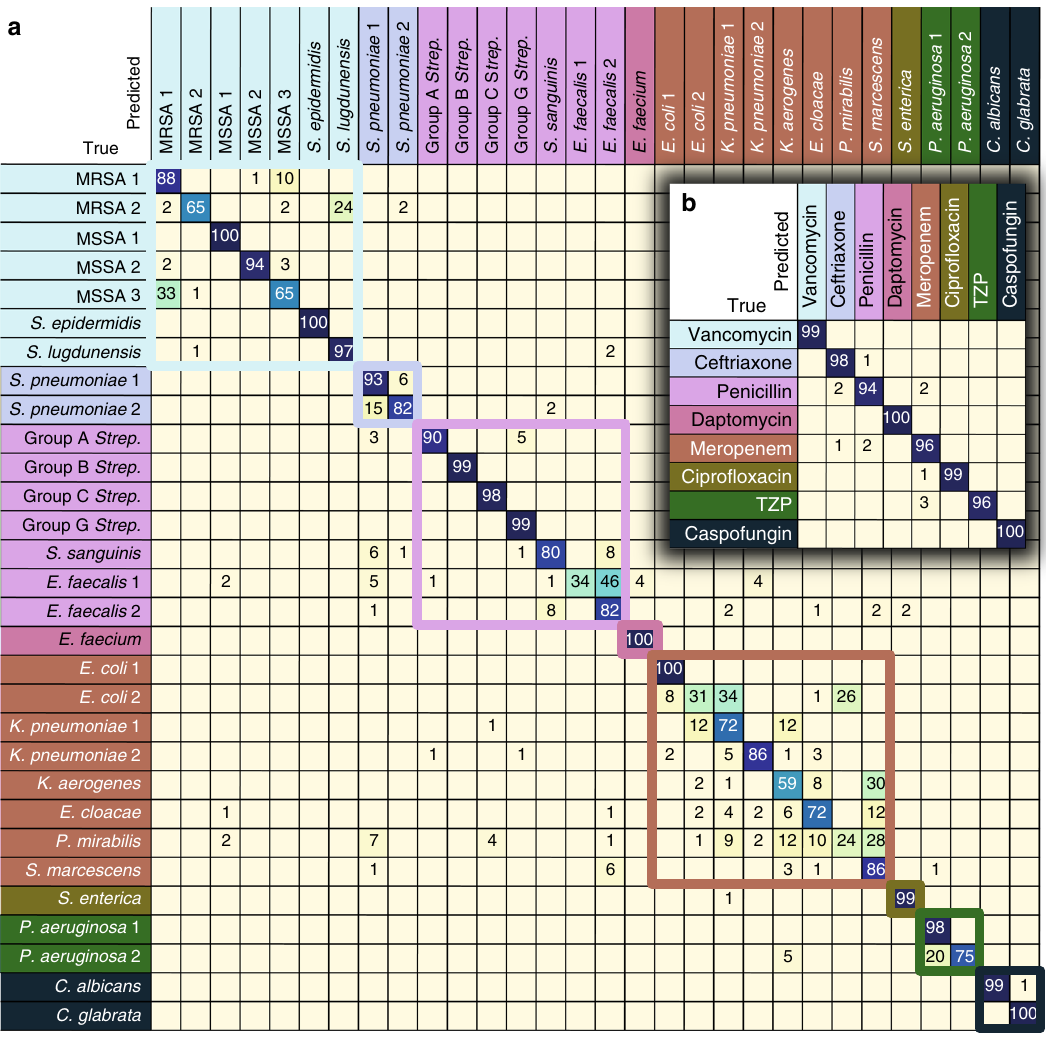
Fig. 2 CNN performance breakdown by class. The trained CNN classi fi es 30 bacterial and yeast isolates with isolate-level accuracy of 82.2±0.3% and antibiotic grouping-level accuracy of 97.0±0.3% (± calculated as standard deviation across 5 train and validation splits). a Confusion matrix for 30 strain classes. Entry i, j represents the percentage out of 100 test spectra that are predicted by the CNN as class j given a ground truth of class i; entries along the diagonal represent the accuracies for each class. Misclassi fi cations are mostly within antibiotic groupings, indicated by colored boxes, and thus do not affect the treatment outcome. Values below 0.5% are not shown, and matrix entries covered by fi gure insets are all below 0.5% aside from a 2% misclassi fi cation of MRSA 2 as P. aeruginosa 1 and 1% misclassi fi cation of Group B Strep . as K. aerogenes . b Predictions can be combined into antibiotic groupings to estimate treatment accuracy. TZP = piperacillin-tazobactam. All values below 0.5% are not